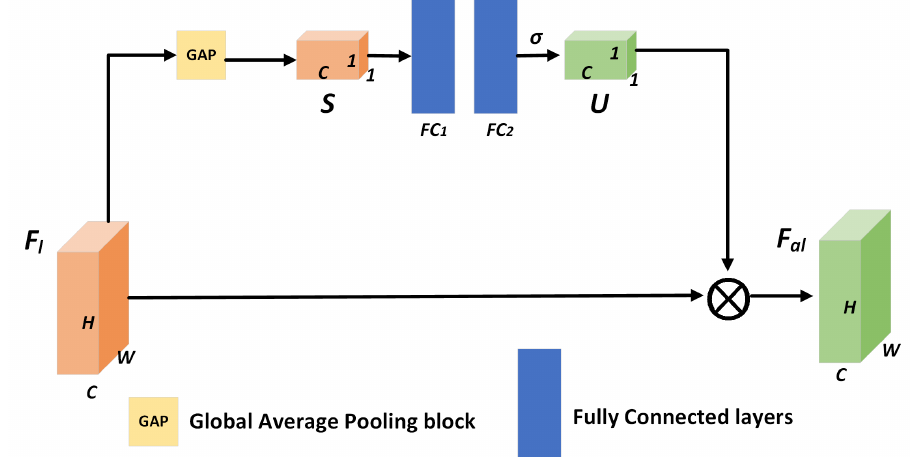
Figure 3. The operation process of the SE-Net. The channel descriptors are first generated by global average pooling, then the attention values are calculated by the fully-connected layers. Finally, the channel-refined features can be calculated by performing channel-wise multiplication. ⊗ represents the channel-wise multiplication operation and σ denotes the sigmoid